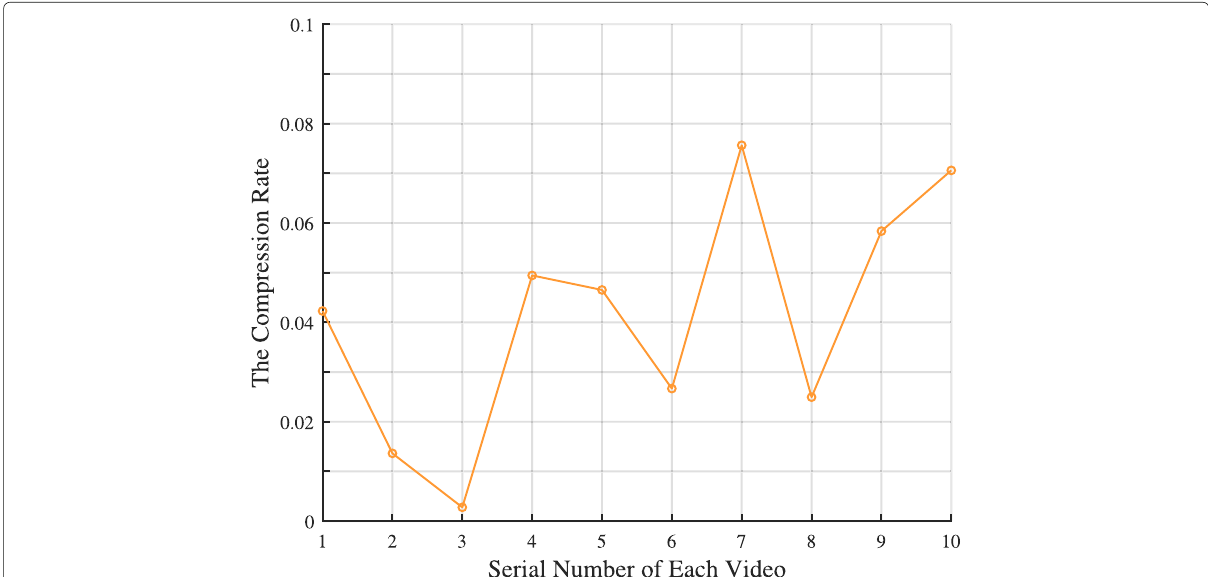
Fig. 6 The compression rate of side information using the same Huffman coding